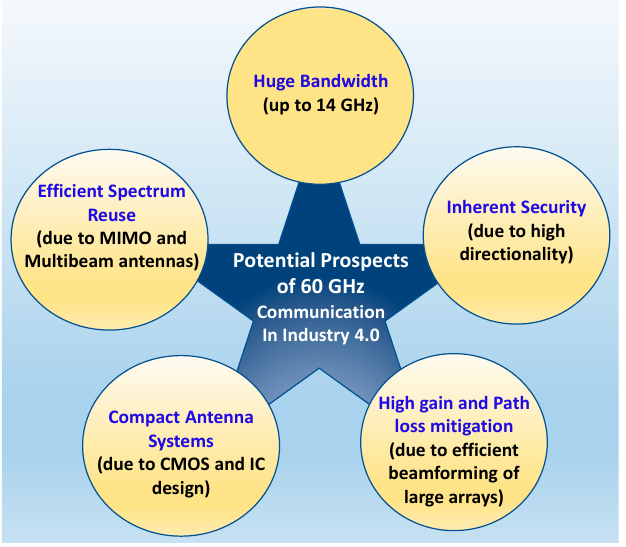
Figure 4. Advantages of 60 GHz mmWave communication in Industry 4.0 and beyond.